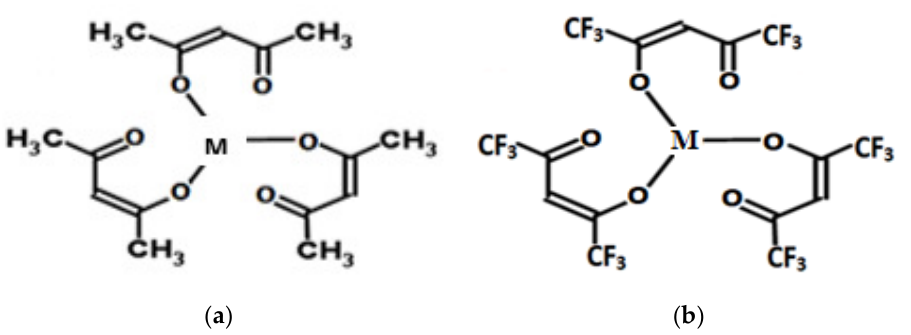
Figure 1. Chemical structures of ( a ) metal acetylacetonate and ( b ) metal hexafluoroacetylacetone, where M = Ce or La, modified from [24].